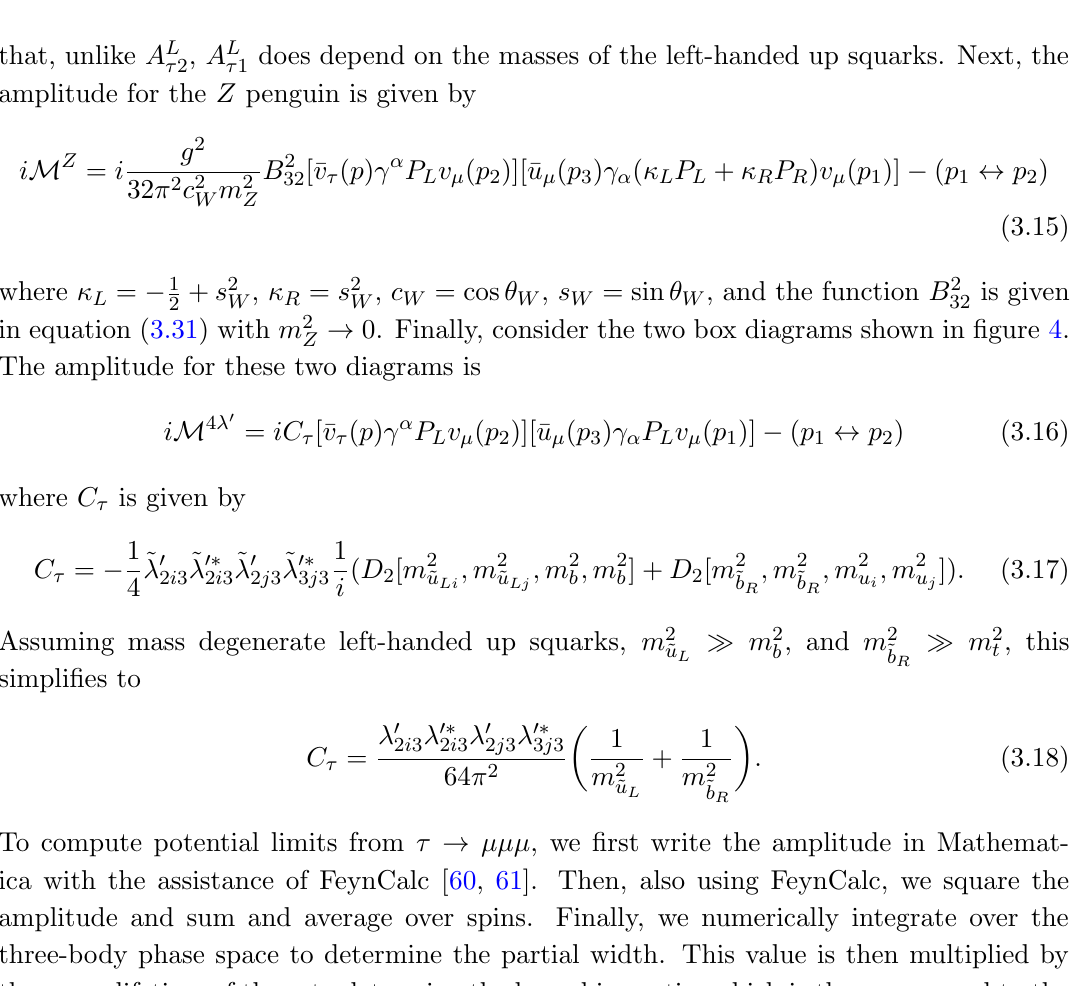
Figure 4 . One loop box diagrams contributing to (cid:28) ! (cid:22)(cid:22)(cid:22)